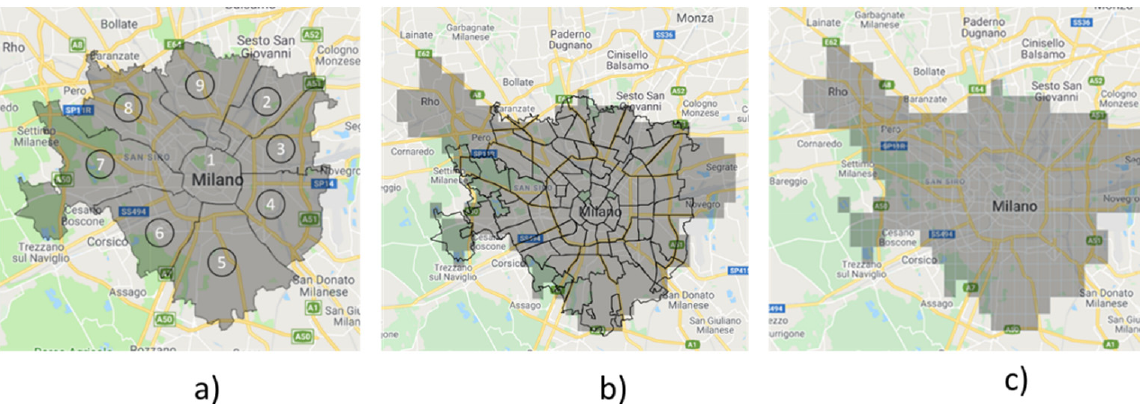
Figure 2. ( a ) Territory division for the data aggregation into 9 municipalities. ( b ) Territory division for the data aggregation into 88 NIL. ( c ) Territory division for the data aggregation into 306 squares of 1 km 2 .